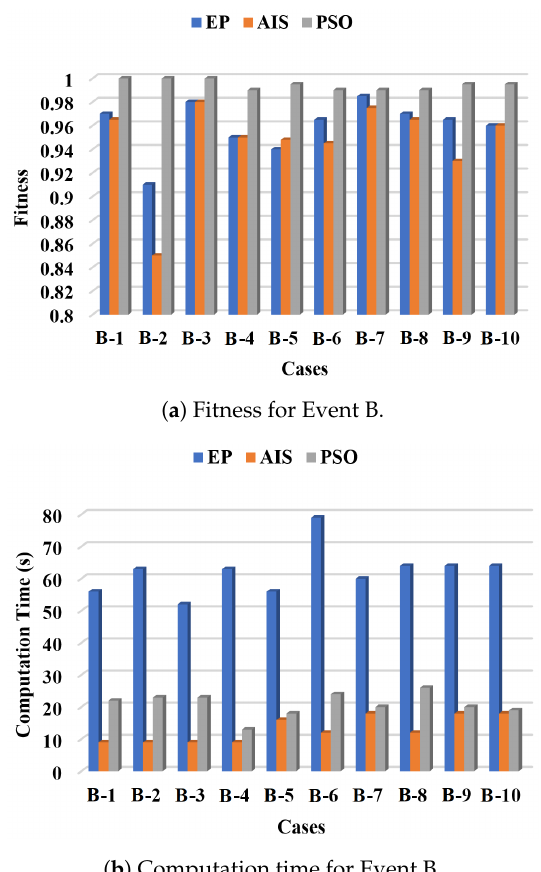
Figure 8. Fitness and computation time for Event